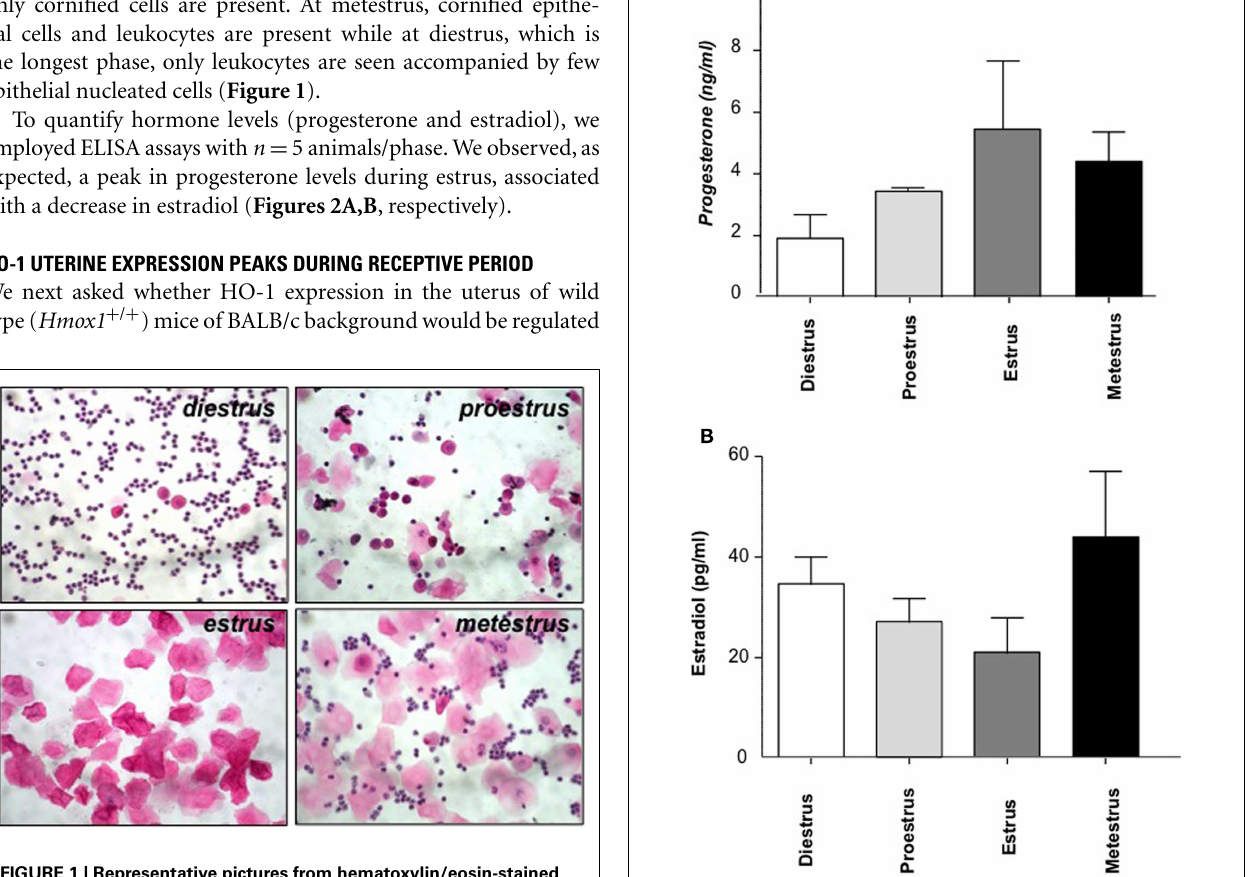
FIGURE 1 | Representative pictures from hematoxylin/eosin-stained samples from vaginal lavage at each phase of the estrous cycle in Hmox1 + / + BALB/c female mice . At diestrus, only leukocytes can be observed, accompanied by few epithelial nucleated cells. At proestrus, mostly nucleated and few cornified cells are present along with some leukocytes. In estrus (at receptivity), only cornified cells are present. At metestrus, cornified epithelial cells and leukocytes are present.